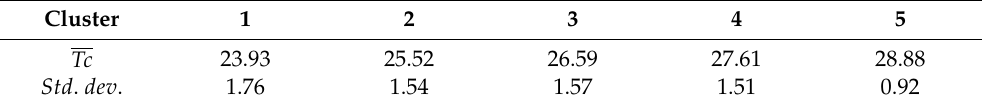
Table 1. Average and standard deviation of the temperature ( ◦ C) for the Control Group, per cluster.